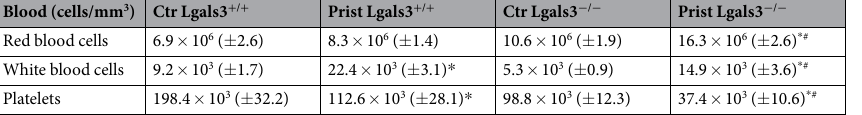
Table 1. Hematological parameters in the blood 18 h after pristane injection. Ctr: control mice; Prist: pristane- injected mice. ( * ) indicates p < 0.05 to pristane-treated mice compared with respective controls. ( # ) indicates p < 0.05 to pristane-induced Lgals-3 − / − mice compared with pristane-induced Lgals-3 + / + mice.